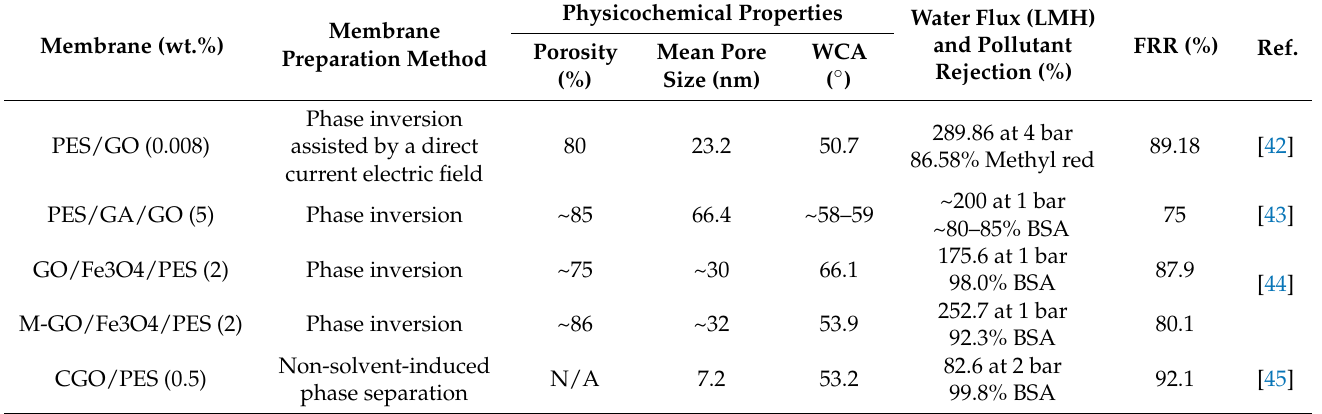
Table 3. Comparison between different PES-based UF hybrid membranes incorporated with MWC- NTs and GO nanoadditives with those prepared in this study for water treatment applications.